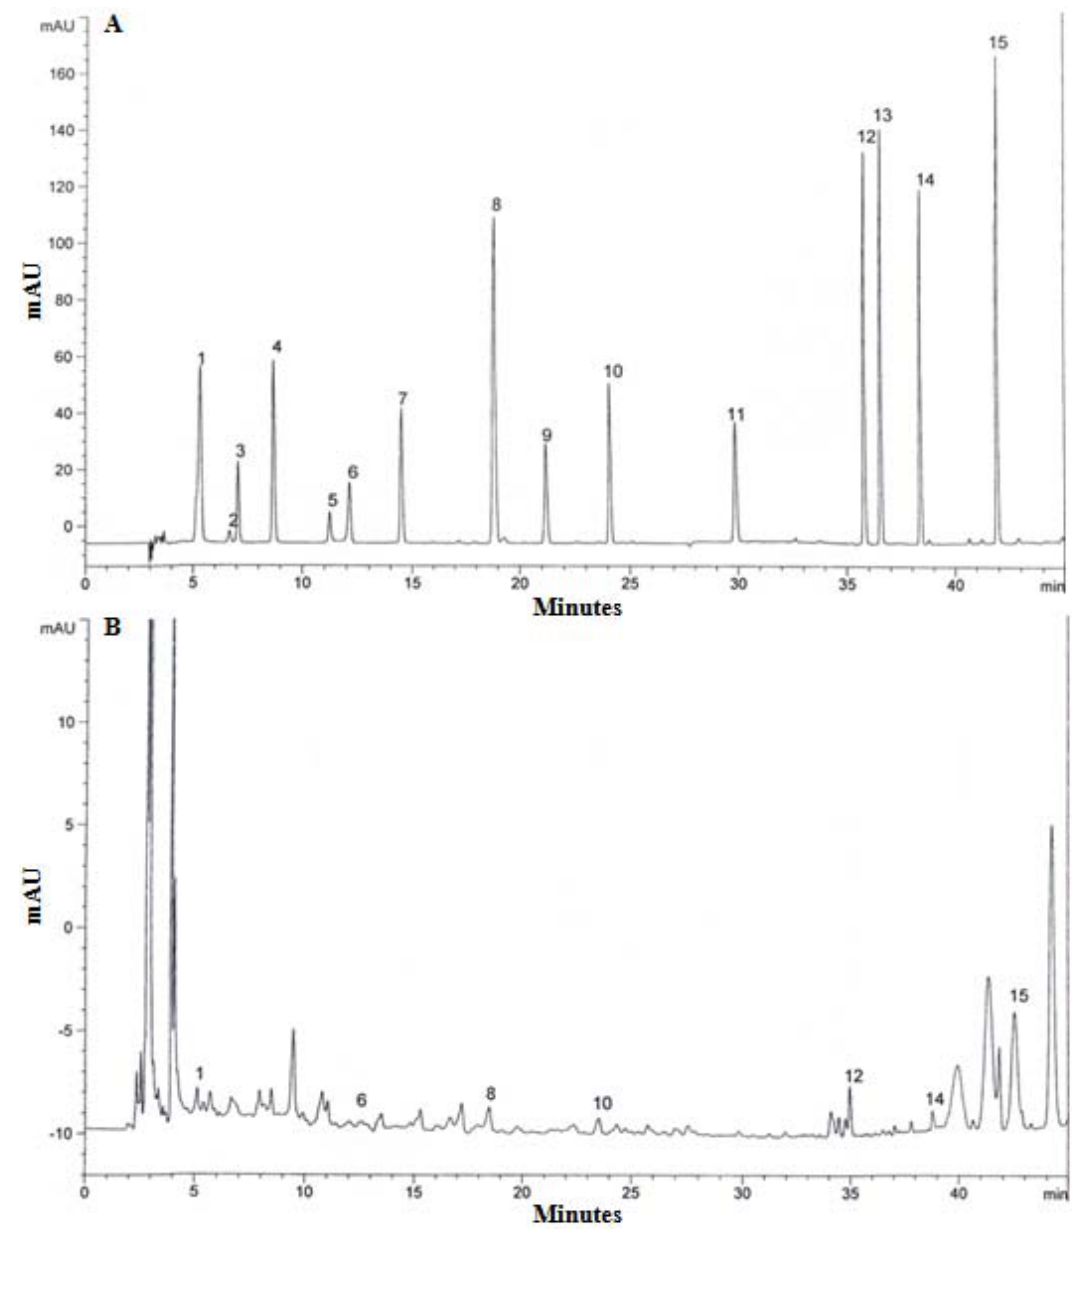
Figure 3. High performance liquid chromatography of phenolic compounds. A, Standard mixture of 15 phenolic compounds; B, Lentinus lepideus extract. 1, gallic acid; 2, pyrogallol; 3, homogentisic acid; 4, protocatechuic acid; 5, ( + ) catechin; 6, chlorogenic acid; 7, caffeic acid; 8, vanillin; 9, ferulic acid; 10, naringin; 11, resveratrol; 12, naringenin; 13, hesperetin; 14, formononetin; 15, biochanin-